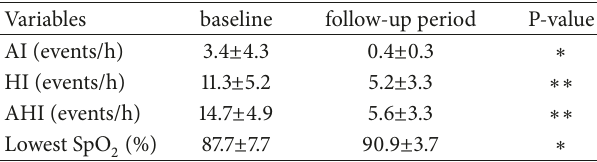
Table 1: Evaluation of the polysomnography